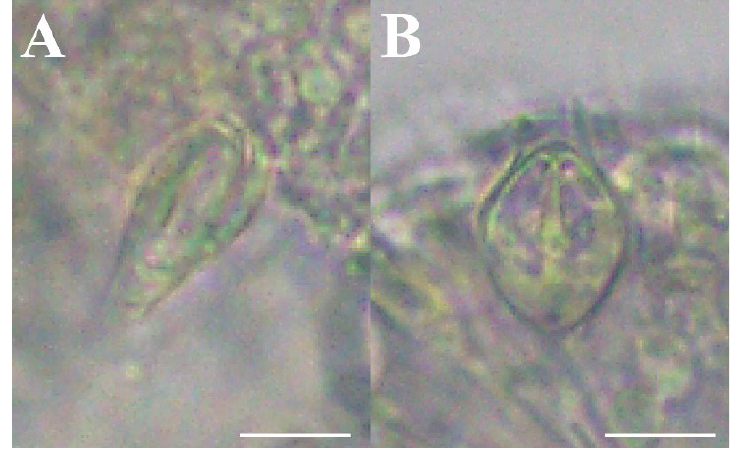
Figure 8. Nematocysts of Octorhopalona saltatrix sp. nov. (unregistered specimen): ( A ) desmoneme, ( B ) stenotele. Scale bars: 10 µm.